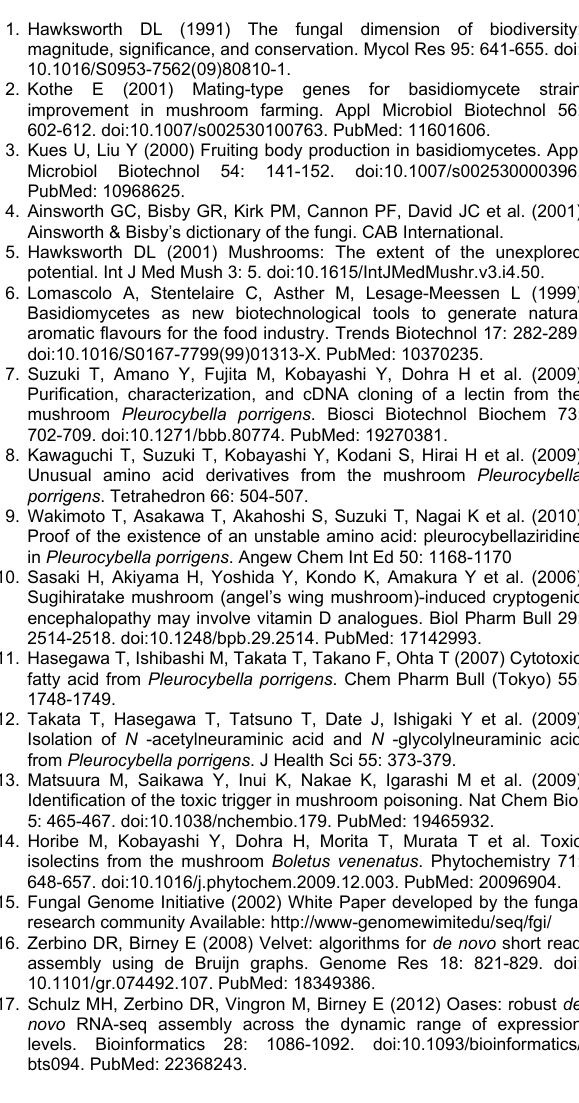
Table S1. The distances between Pleurocybella porrigens and other species (basidiomycetes and ascomycetes) .